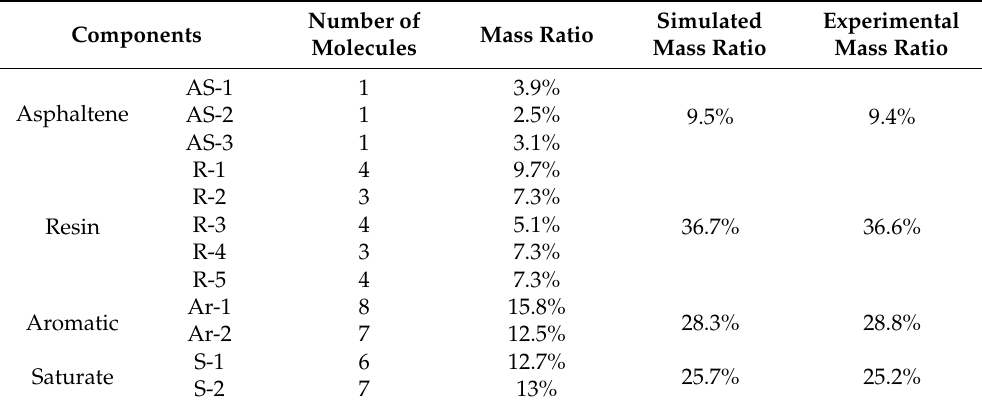
Table 7. Ratio of matrix asphalt component model.